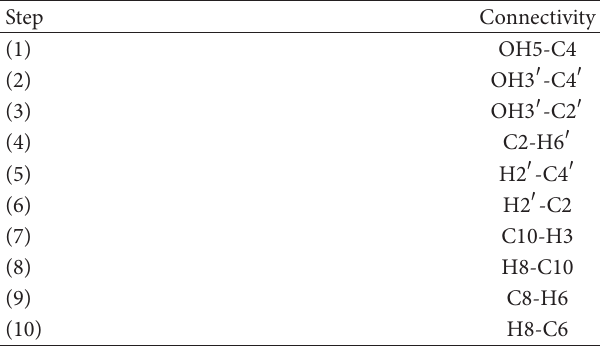
T 1: HMBC connectivities for the assignment luteoline.